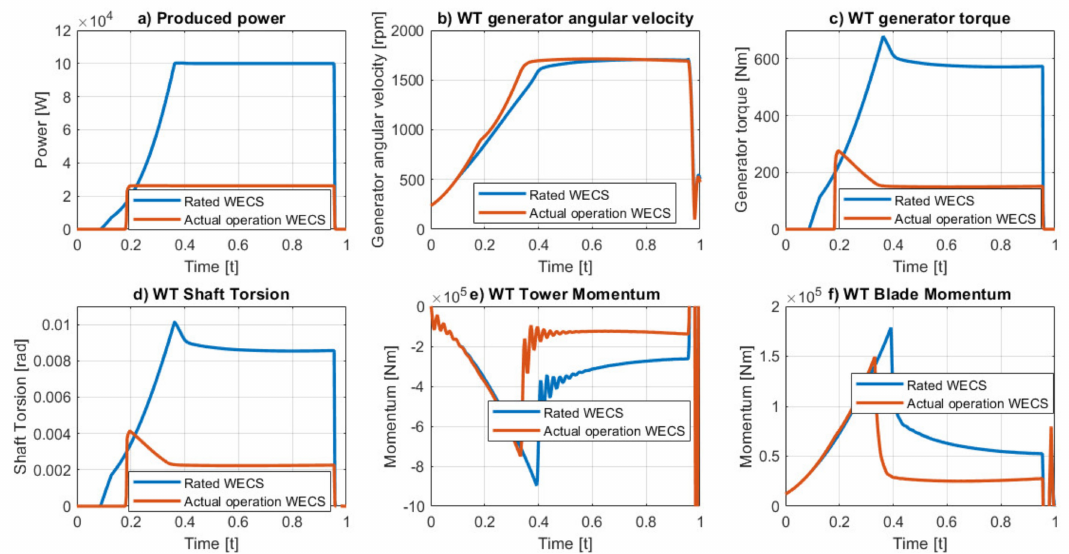
Figure 8. Rated vs actual operation of the WECS comparison: ( a ) power production comparison; ( b ) generator angular velocity comparison; ( c ) generator torque comparison; ( d ) drive train torsion comparison; ( e ) tower momentum comparison; ( f ) blade momentum